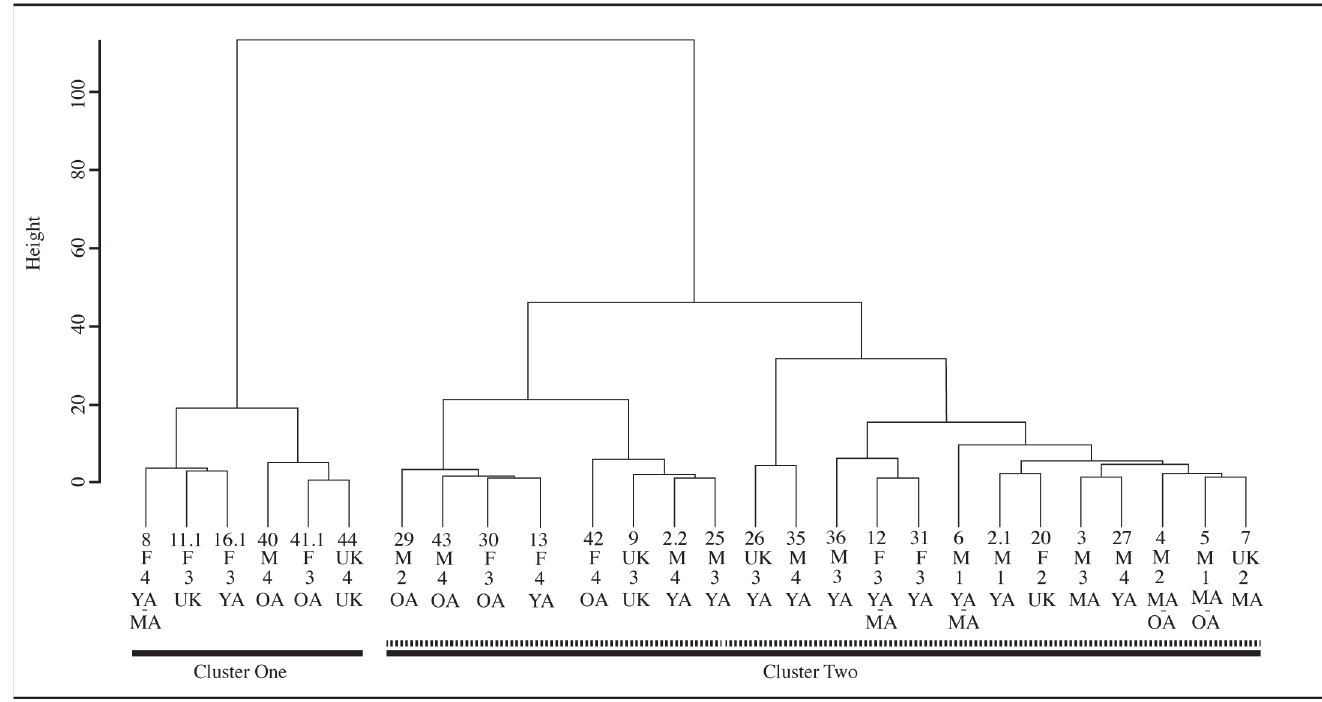
Fig 2. Ward's cluster analysis of dietary stable isotope ( δ 15 N and δ 13 C) values from Wairau Bar with associated age, sex and wealth information.